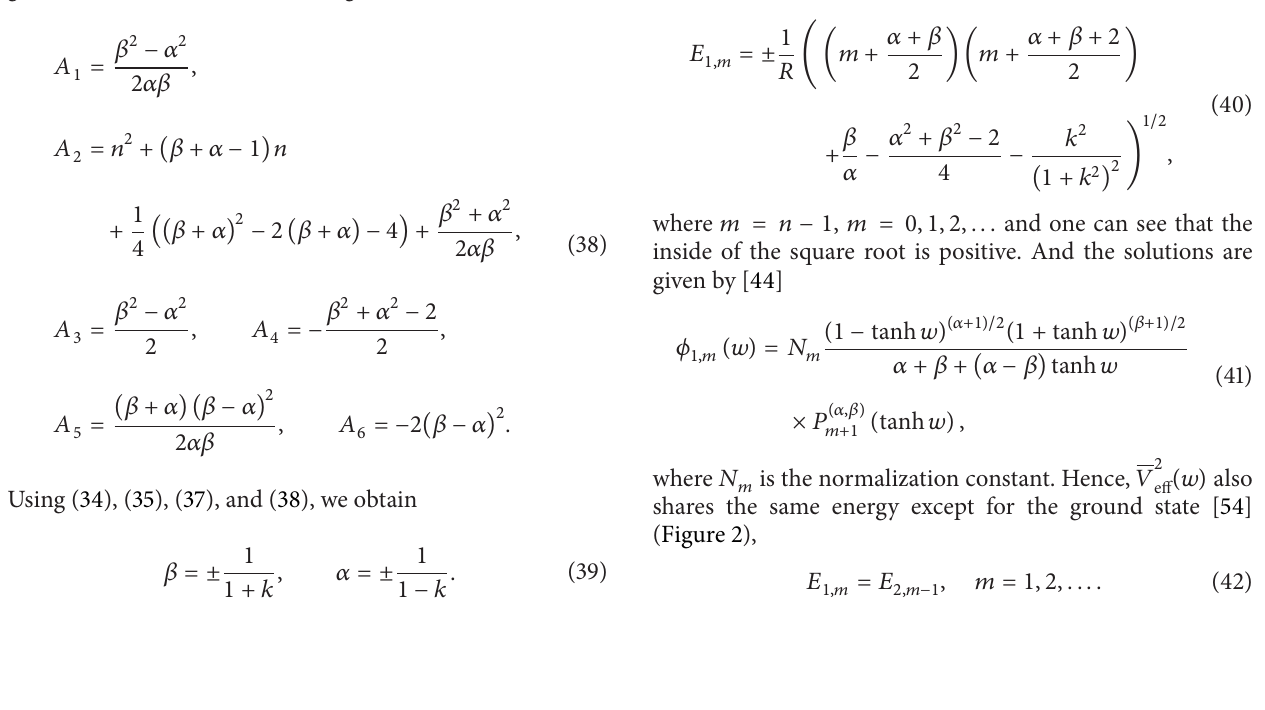
and 𝑉 , and 𝐴 𝑢 (𝑤) have the same singularity point. Energy eigenvalues are increasing. eff ,2 eff ,1